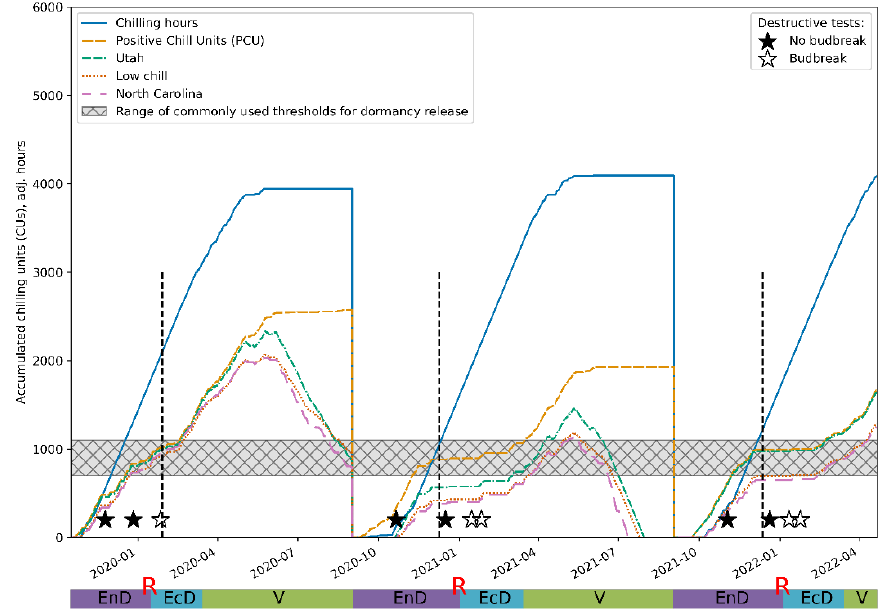
Figure 7. Comparison of the predictions of the endo-dormancy obtained using the wavelet analysis of the DI 0 /RC time series (see Figures 5 and 6) and those inferred from the established CR models (see Materials and Methods). The vertical dashed lines denote the transition from endo-dormancy to eco-dormancy.